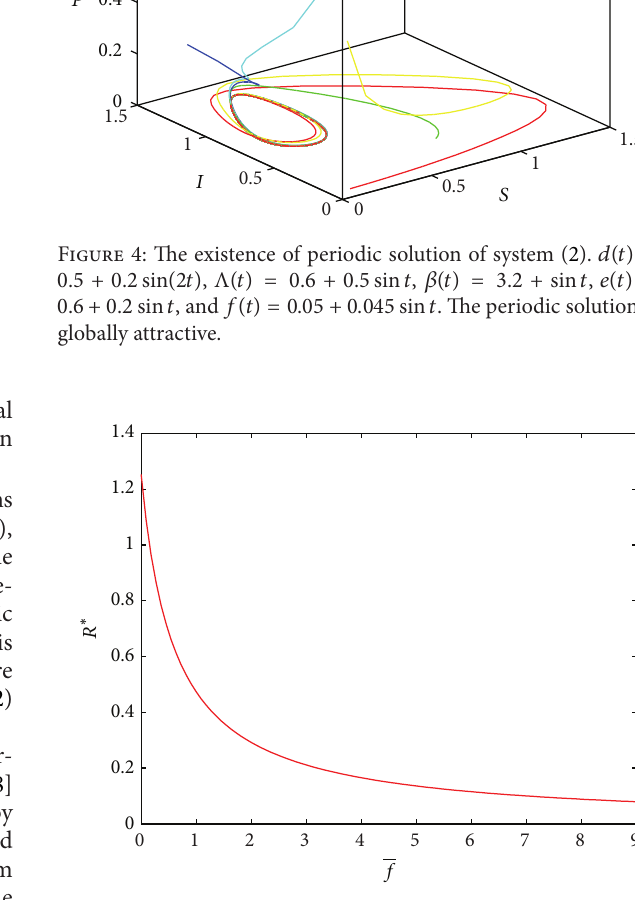
Figure 5: The graph of the upper threshold value 𝑅 ∗ versus 𝑓